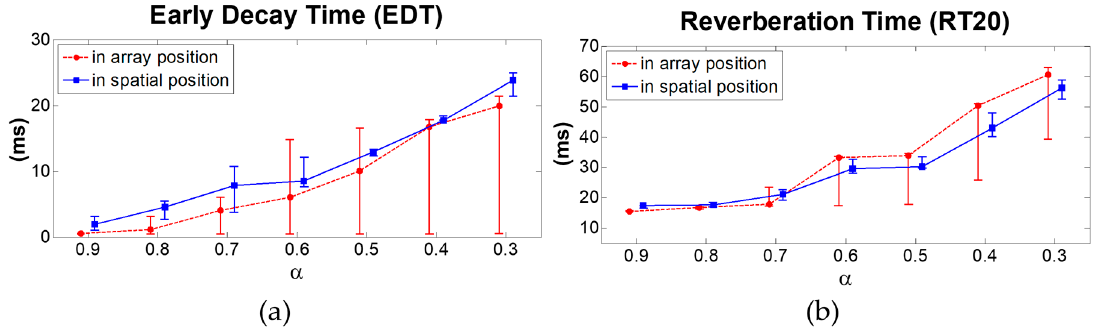
Figure 12. Comparison of analysis results between microphones in the array position (MIC1–MIC7) and microphones in the spatial position (MIC8–MIC11, positions A, B, C, and D) usingthe ( a ) early decay time and ( b ) reverberation time.